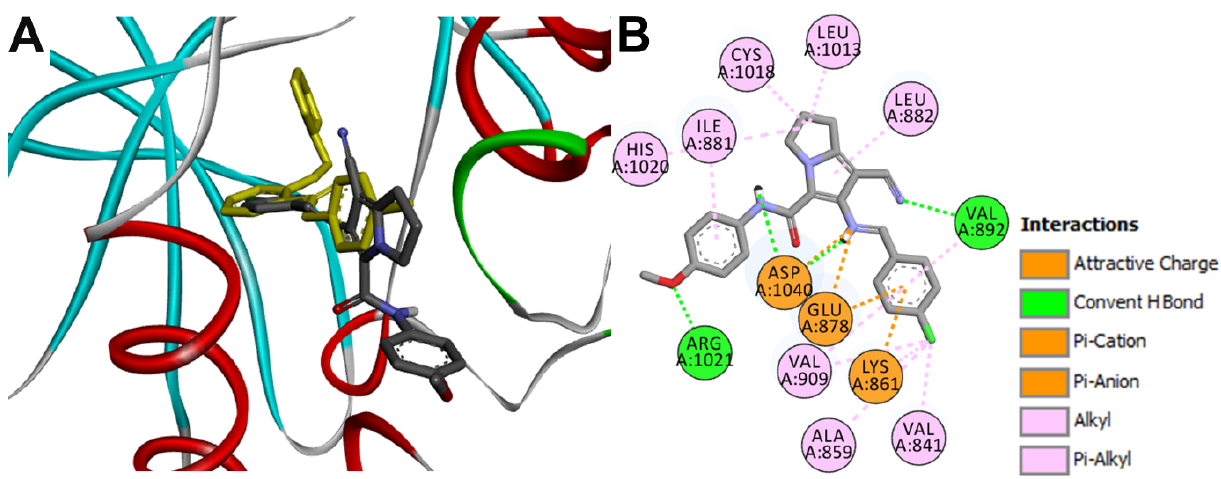
Figure 21. Binding mode of compound 16g (shown as sticks colored by element) into VEGFR1 (pdb: 3HNG): ( A ) 3D binding mode of the best-ranked pose of compound 16g overlaid with the co-crystallized ligand, 8ST (yellow sticks); ( B ) 2D binding mode of compound 16g showing different types of interactions with amino acids in VEGFR1.